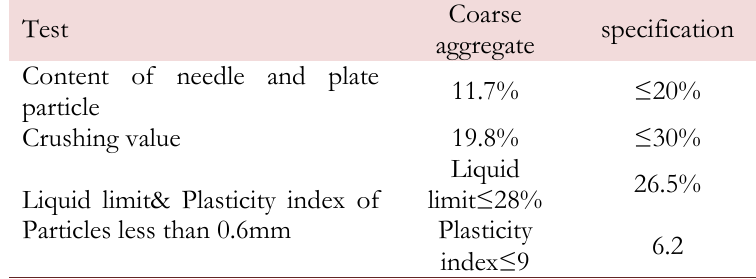
Table 2: The characterization of the limestone aggregate.